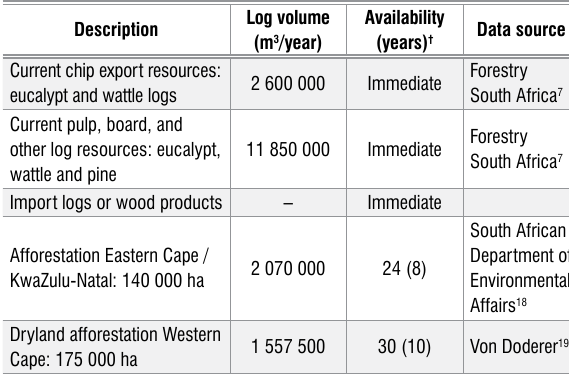
Potential future log resources available for timber-based housing components such as sawn timber and board products